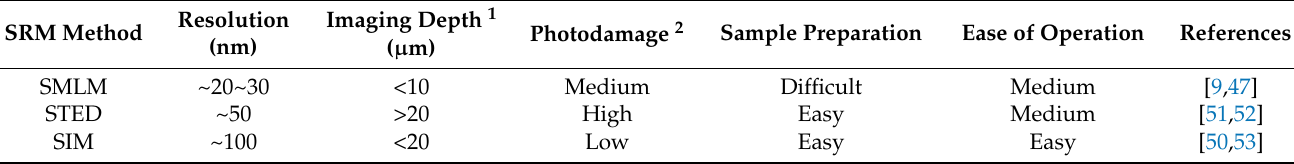
Table 2. Comparison of several SRM methods.